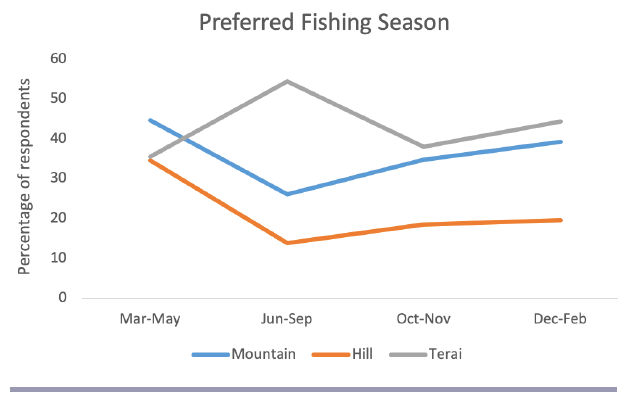
Fig. 5. Percentage of respondents’ preferred seasons for fishing for communities in each of three regions across the Karnali basin. N =